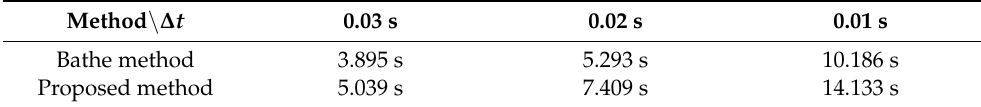
Figure 23. Displacement responses of Point A from 14 to 15 s with the Bathe method and the proposed method using different time steps. Table 3. Computational time of Bathe method and proposed